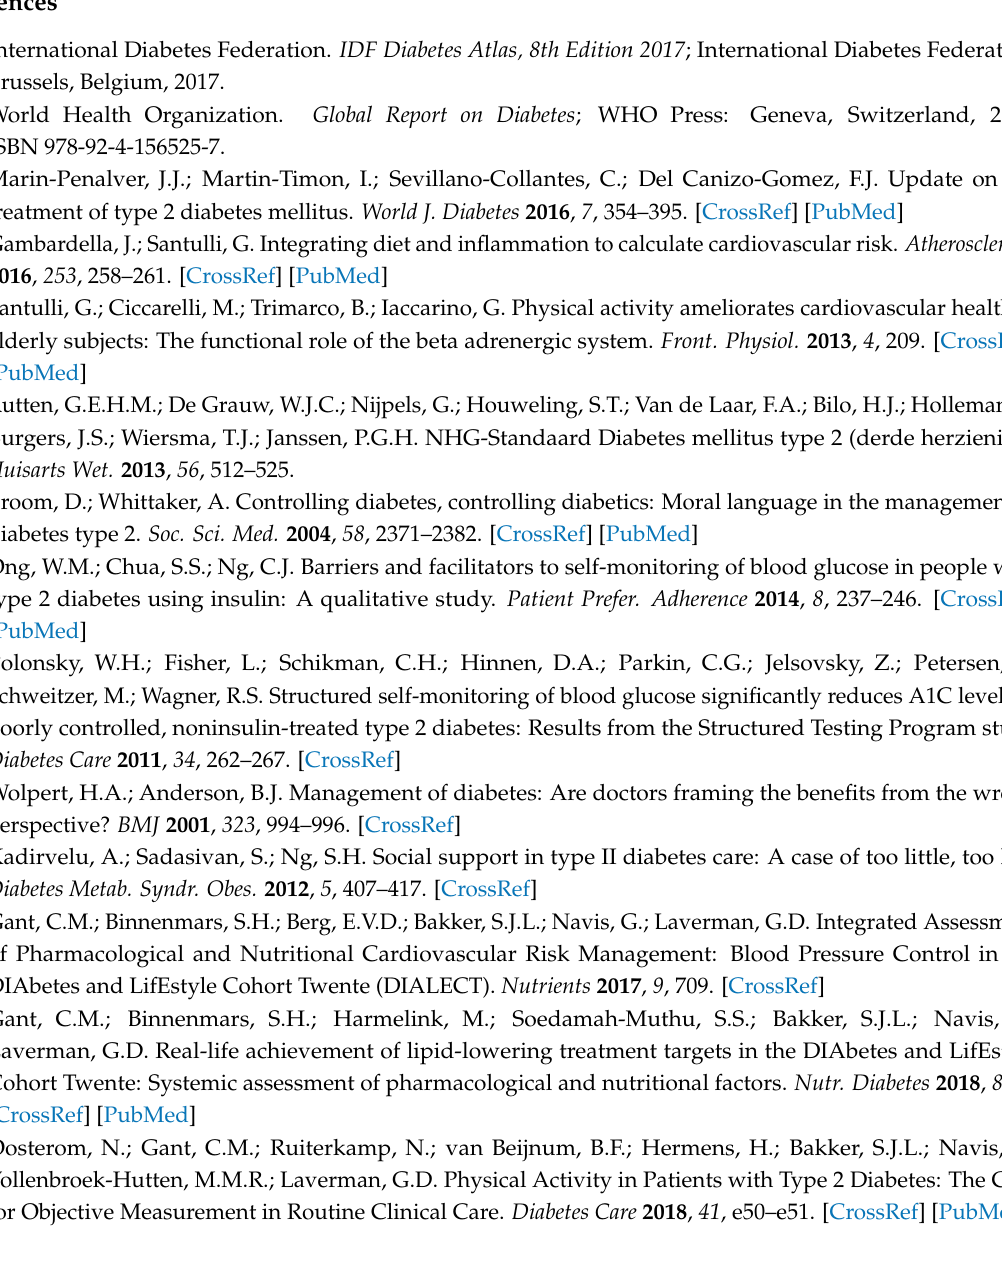
Diameter, Table S3: requirements of the glucose measurement part of the Diameter, Table S4: requirements of the shared part of the